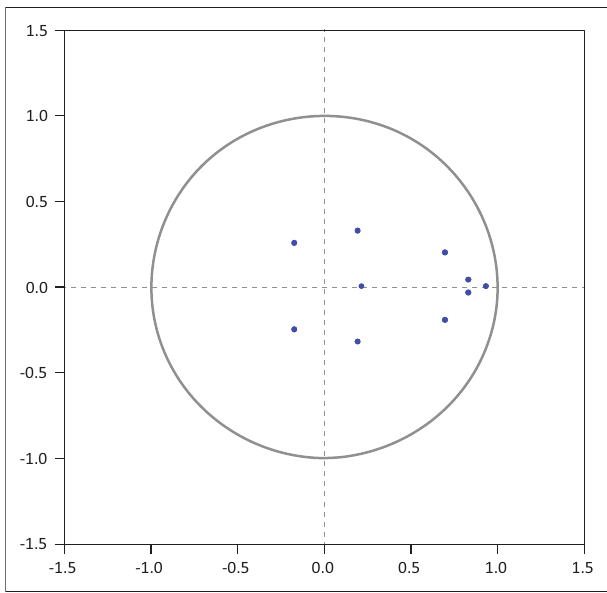
FIGURE 2-A1: Stability test for constant parameter vector autoregressive